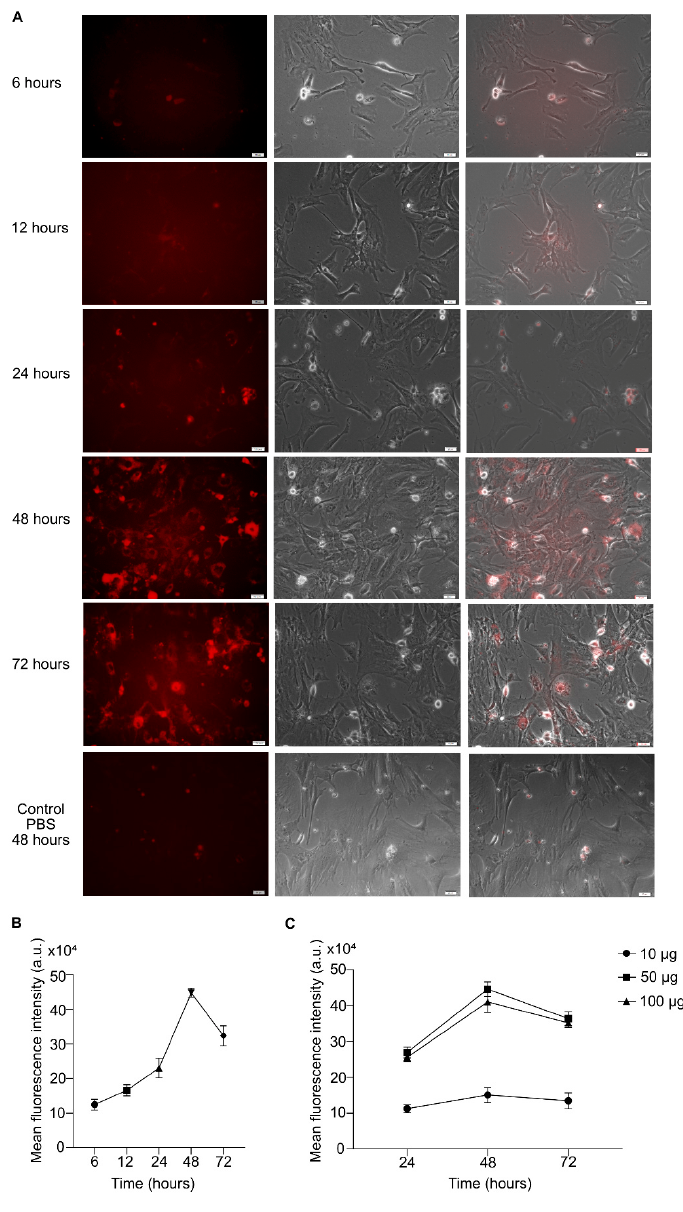
Figure 2. Internalization of the labeled mouse insulinoma (MIN6)-derived exosomes by the MEFs. ( A ) Fluorescence microscopy images depicting the time-dependent internalization of ExoGlow-labeled exosomes (red) by MEF cells. Scale bar = 20 µm. The first panel shows MEFs that have successfully